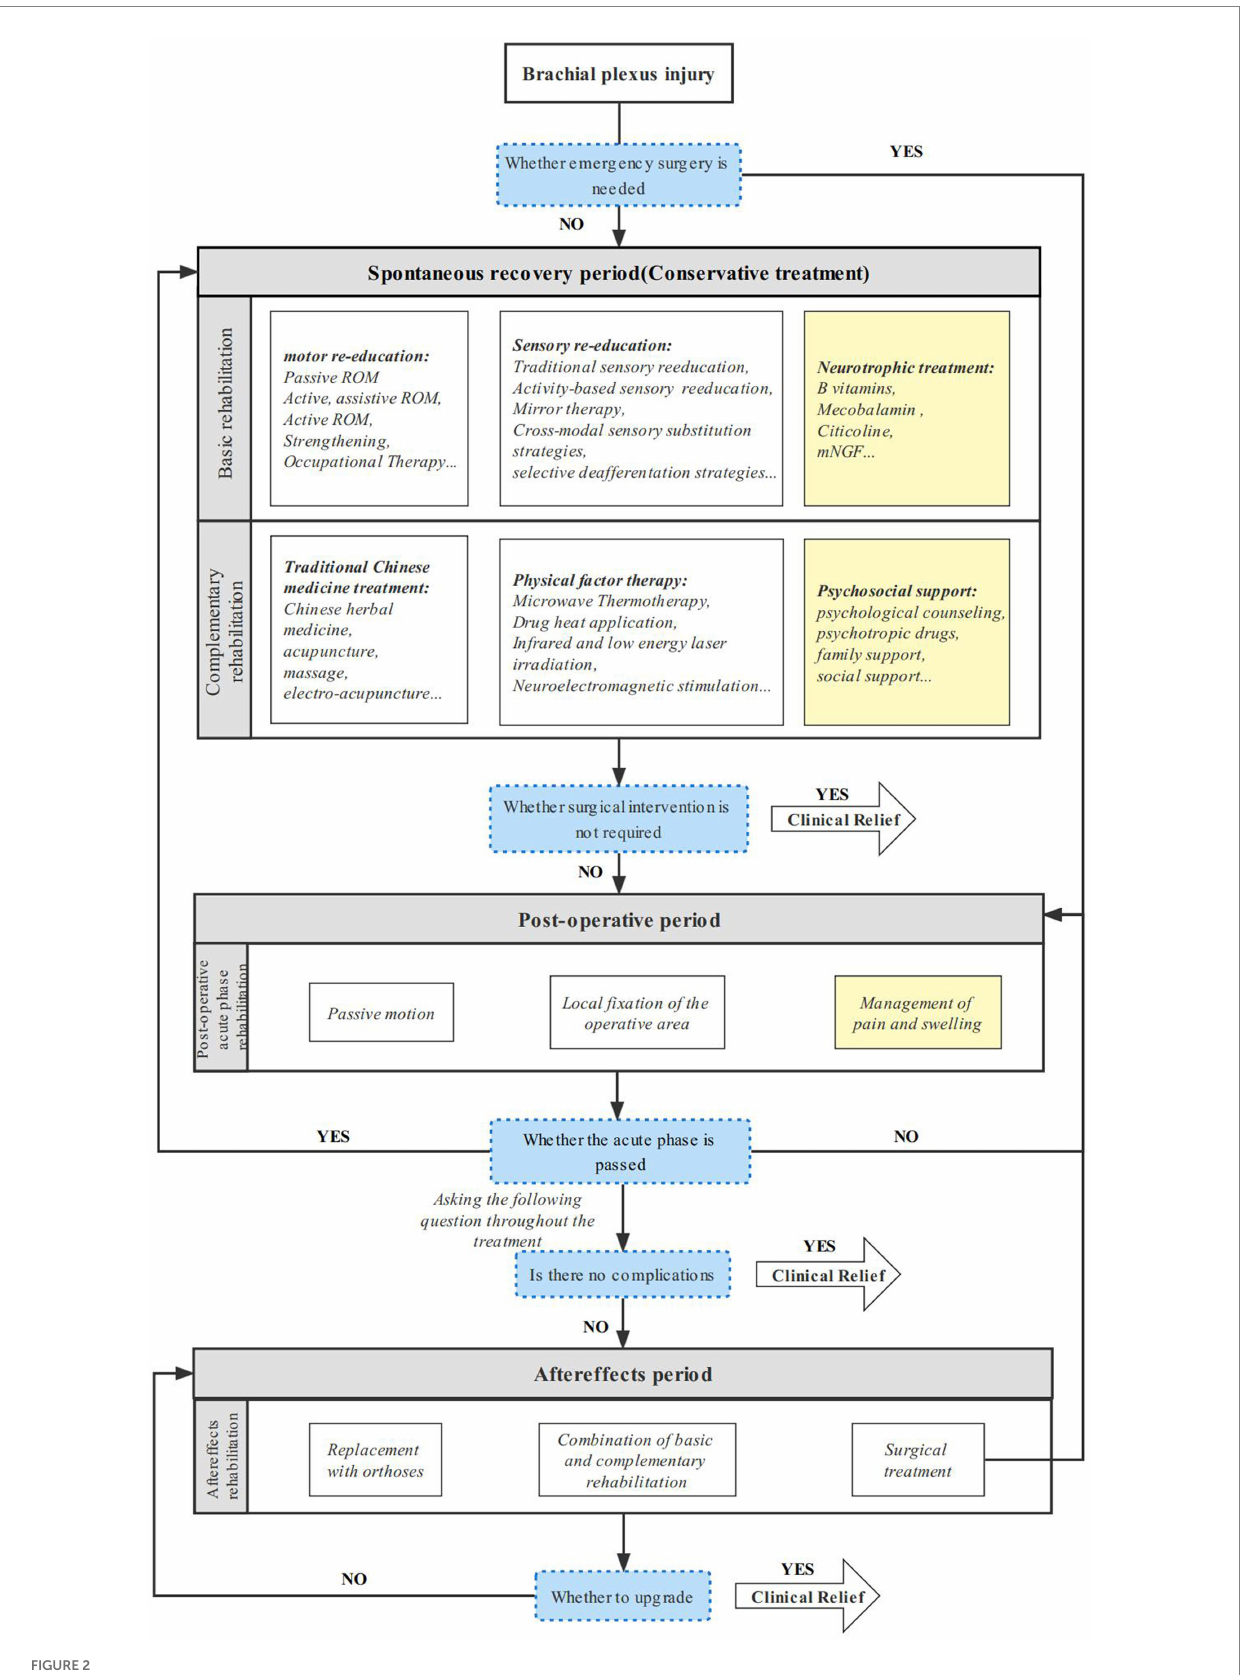
FIGURE 2 Comprehensive rehabilitation protocol for brachial plexus injury. A sustainable and comprehensive rehabilitation protocol for adult brachial plexus injury in different